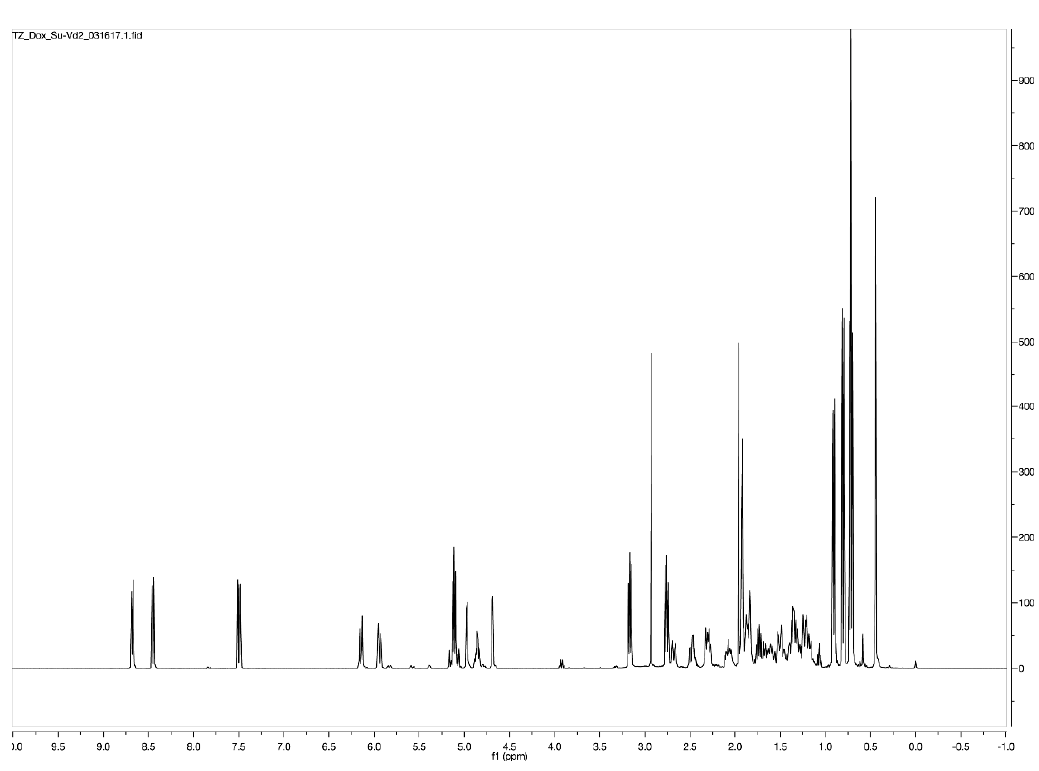
Figure 2. Schematic 1 HNMR diagram of DOX-Vit D.